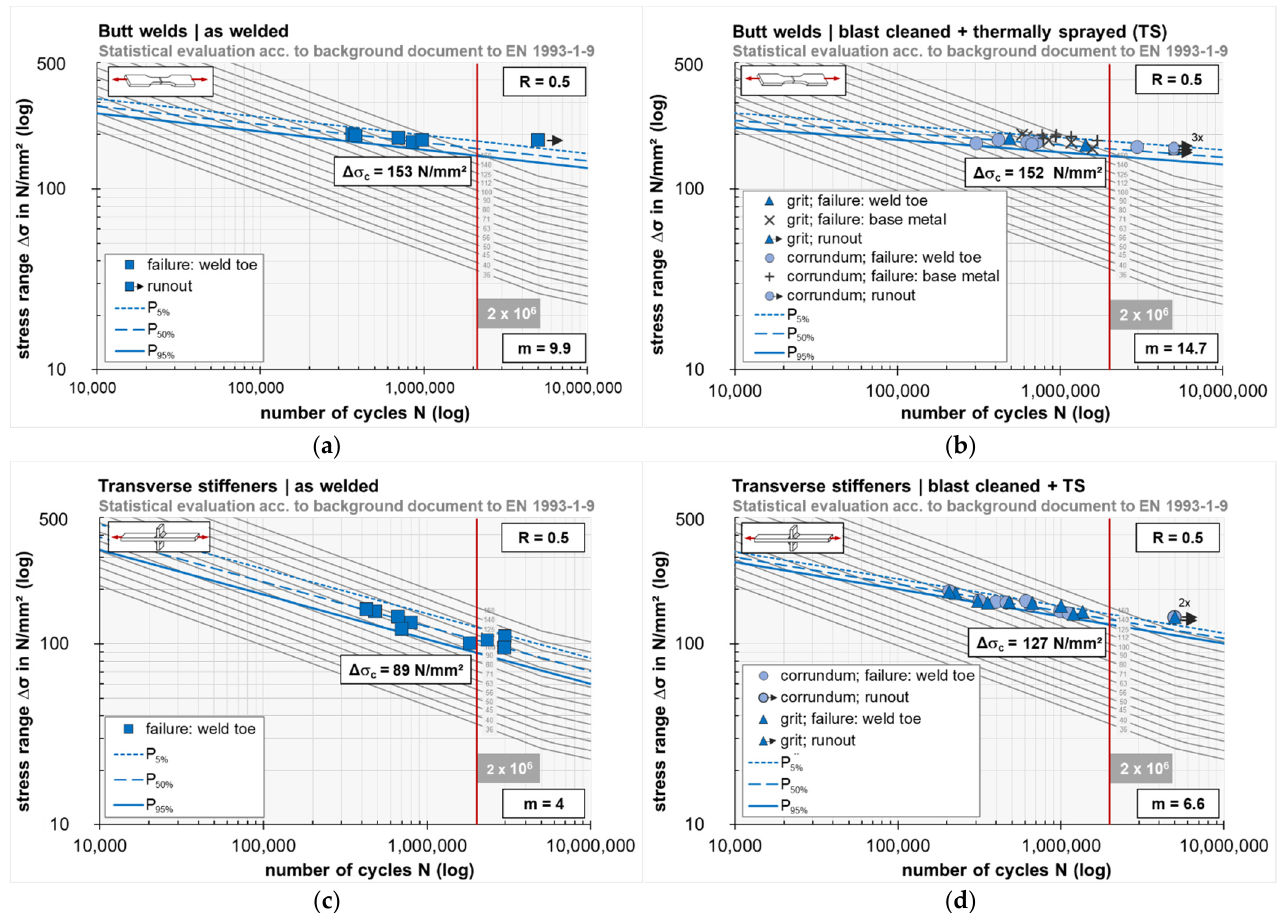
Figure 9. S–N Diagrams. ( a ) butt-welded specimens, as welded; ( b ) butt-welded specimens, blast cleaned and thermal spray coated; ( c ) specimens with transverse stiffeners, as welded; ( d ) specimens with transverse stiffeners, blast cleaned, and thermal spray coated.